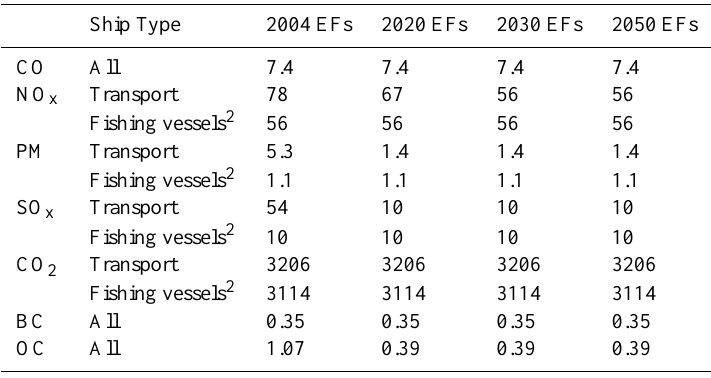
Table 2. Gas and PM emission factors applied to current and future Arctic shipping (g/kgfuel) 1 .